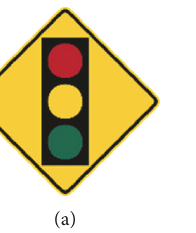
Figure 1: Signal ahead sign and marking at a signalized intersection, flashing-light ahead sign at a grade crossing. (a) Signal ahead sign (MUTCD); (b) signal ahead marking (MUTCD); and (c) flashing-light ahead sign (New Zealand,